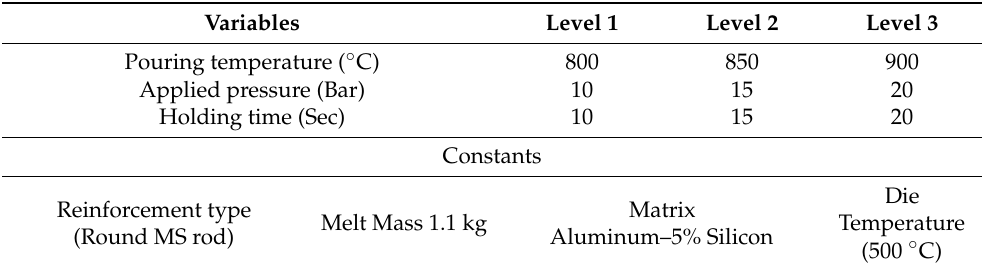
Figure 2. Experimental setup. Table 1. Design of